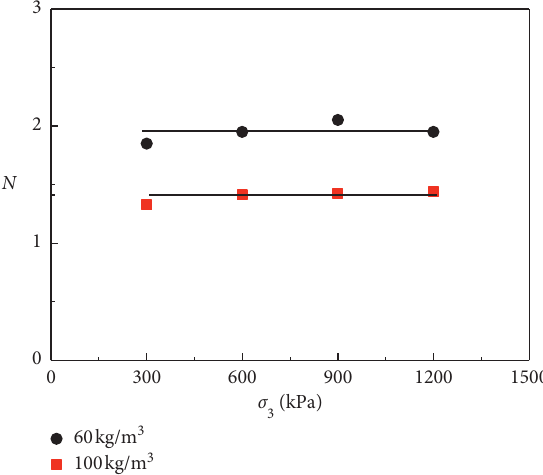
Figure 11: Relationship between parameter N and confining pressure, σ